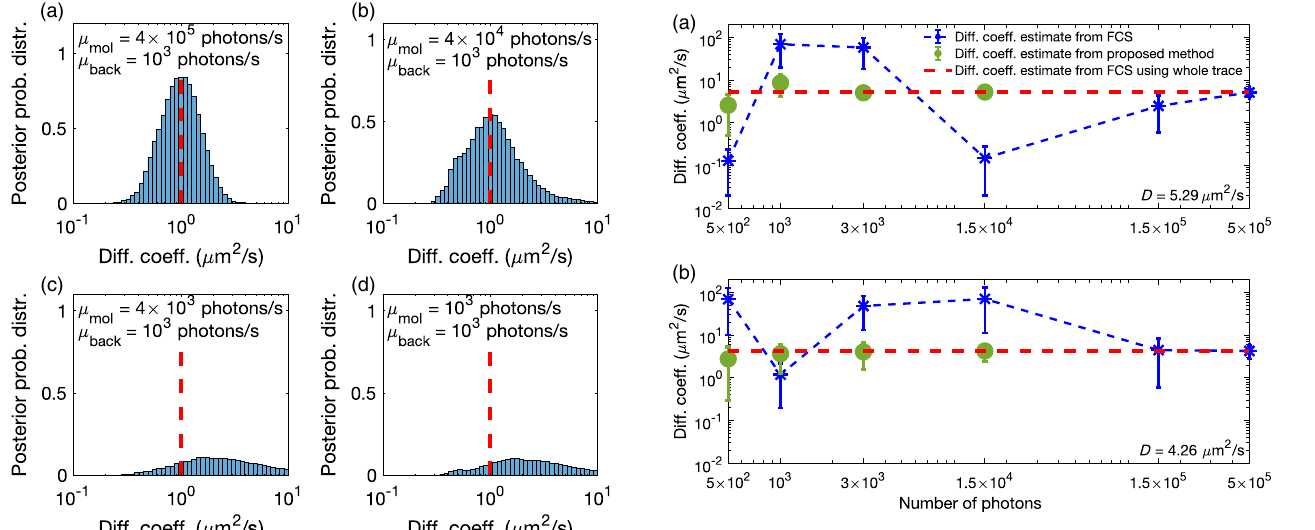
FIG. 7. A higher molecule photon emission rate provides more photons per unit time and sharper diffusion-coefficient estimates. (a) – (d) Posterior probability distributions drawn from traces produced by four molecules diffusing at 1 μ m 2 = s for a total time of 30 ms under a background photon emission rate of 10 3 photons = s and molecule photon emission rates 4 × 10 5 , 4 × 10 4 , 4 × 10 3 , 10 3 photons = s, respectively. As expected, under higher molecule photon emission rates, the peak of the posterior matches sharply with the exact value of D (dashed line). Gradually, as we decrease the molecule photon emission rate, the estimation becomes less reliable.